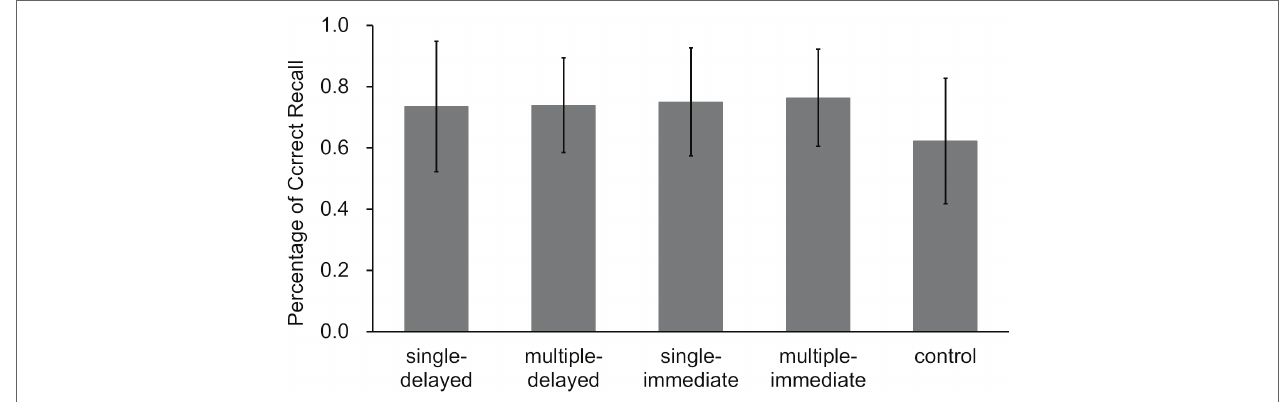
FIGURE 4 | Correct answer rates on the final tests for each learning condition in Experiment 1 (error bars represent SD